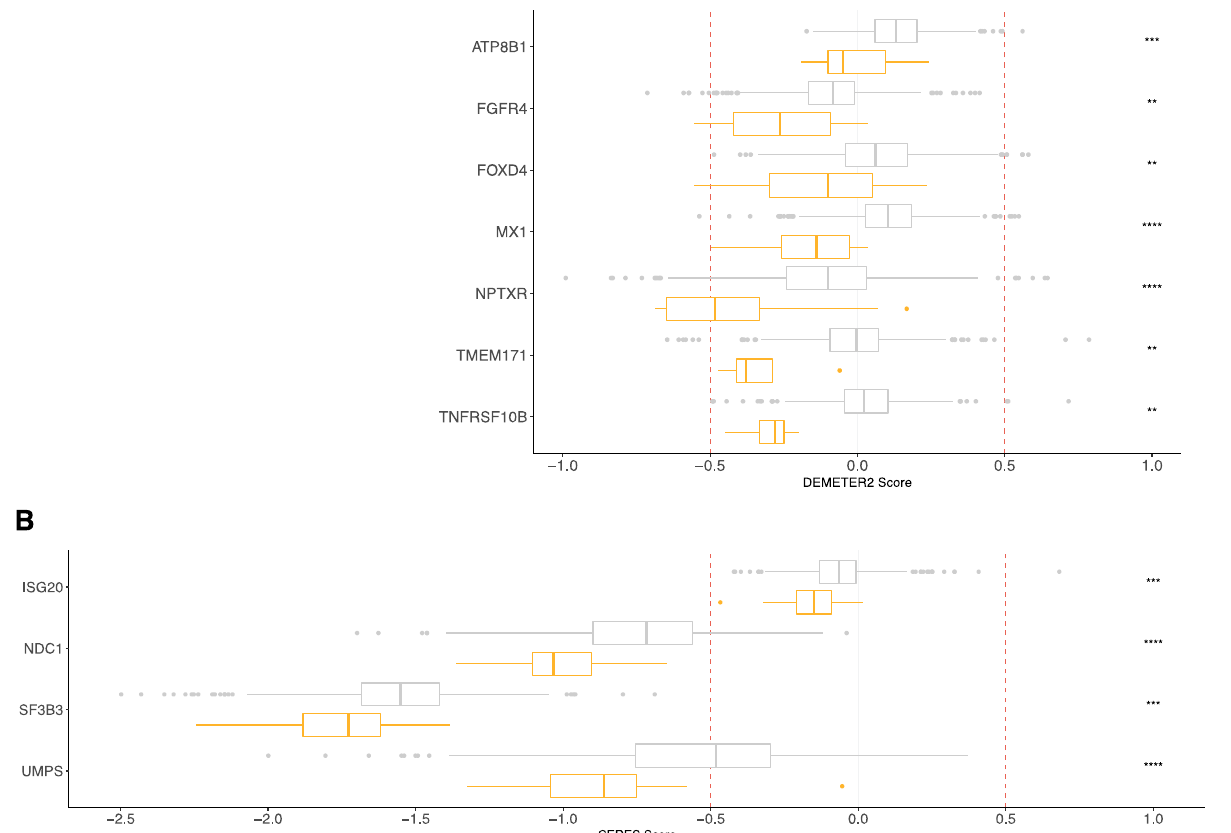
Figure 4. RNA-seq-based risk score revealed genes associated with MM pathophysiology. Boxplots of dependency scores calculated from the Cancer Dependency Map project (https://depmap.org) (28 September 2021). ( A ) RNAi-based viability assays in MM cell lines (n = 16) and other cancer cell lines (n = 695). ( B ) CRISPR/Cas9-based viability assays in MM cell lines (n = 20) and other cancer cell lines (n = 769). DEMETER2 and CERES scores were calculated from RNAi-based and CRISPR–Cas9 viability screens, respectively. A lower score means that a gene is more likely to be dependent in a given cell line. A score of 0 is equivalent to a gene that is not essential, whereas a score of -1 corresponds to the median of all common essential genes. Boxplots in orange represent multiple myeloma cell lines, and boxplots in grey correspond to other cancer cell lines. ** p -value < 0.01, *** p -value < 0.001, **** p -value < 0.0001.